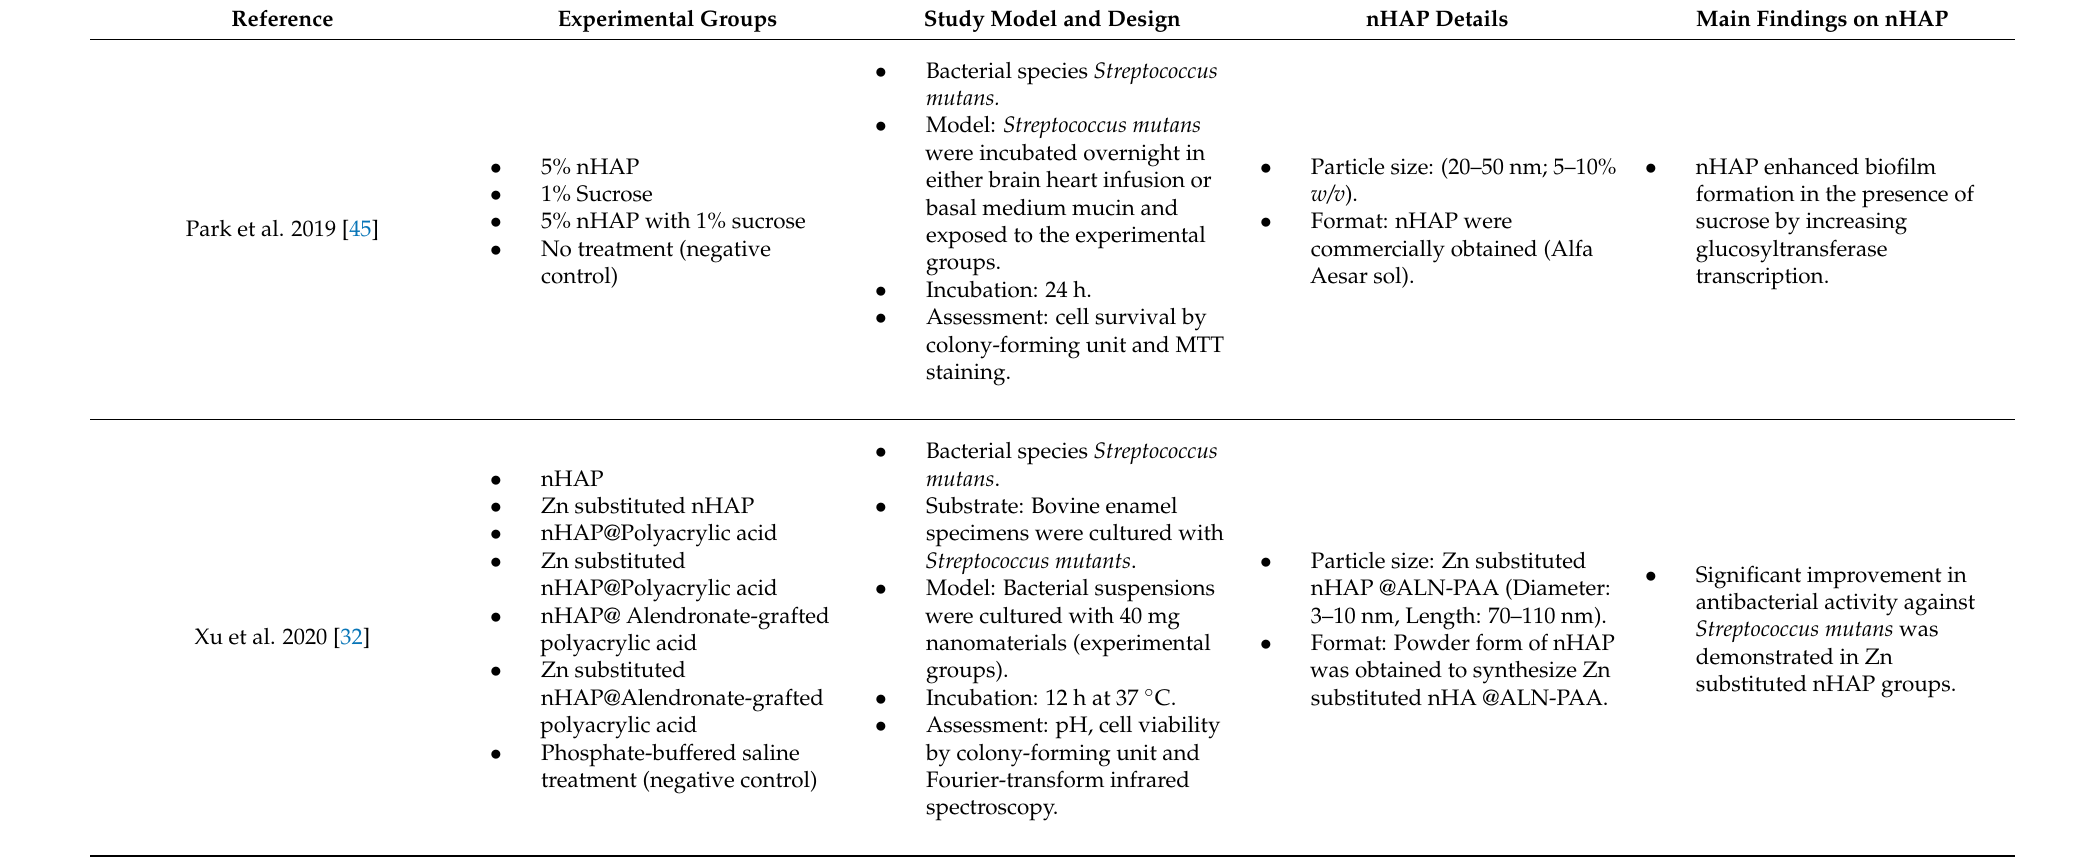
Table 3. Summary of the antimicrobial effect of hydroxyapatite